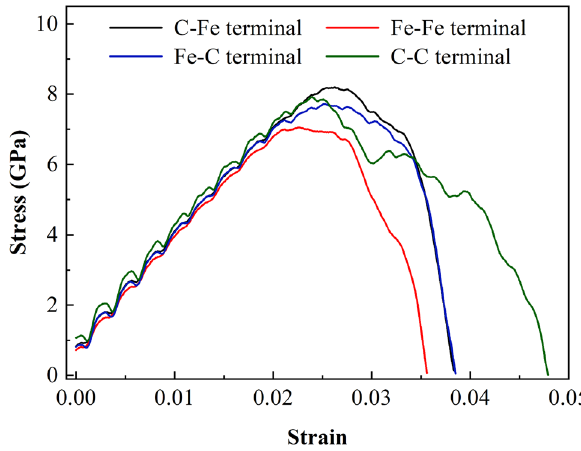
Figure 11. Stress–strain relationship of interface model during axial tension.